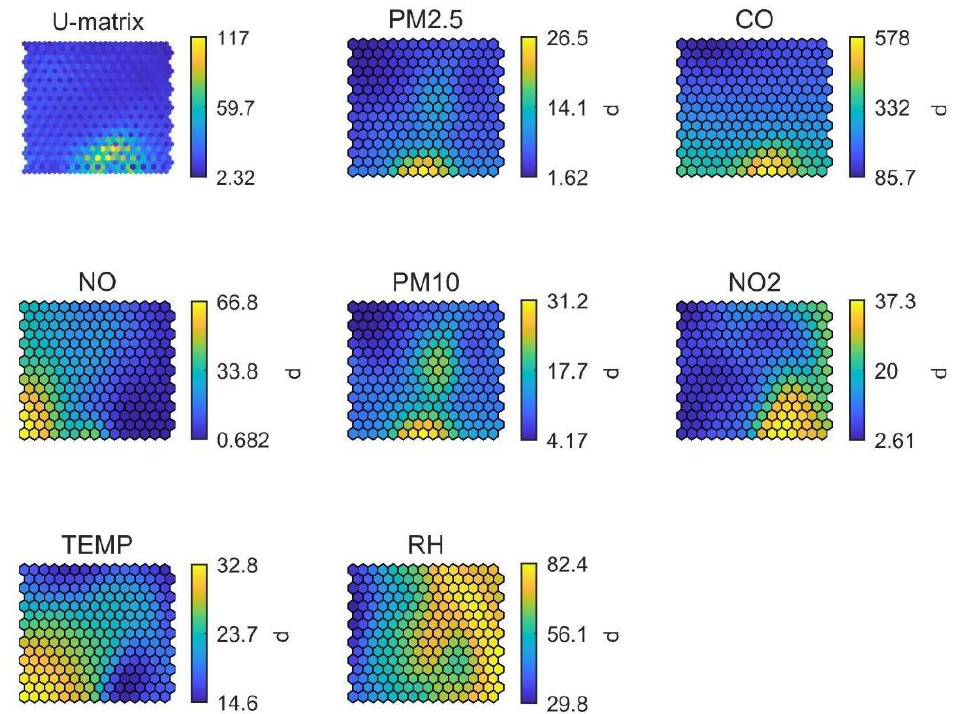
Figure 7. SOM of available data for stadium #3, in Oceania. The colour scale is automatically adjusted among graphs and does not reflect the full range of values per parameter.